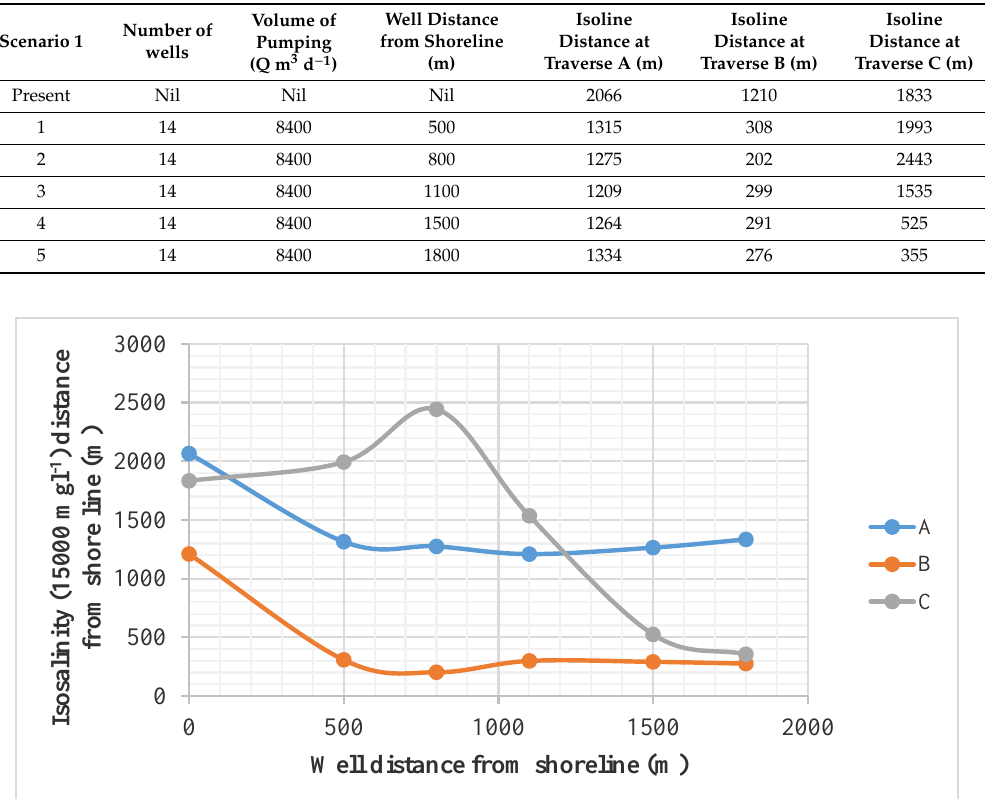
Table 3. Distance of 15,000 mgl − 1 Isosalinity Contour along Traverse A, B and C after Constant